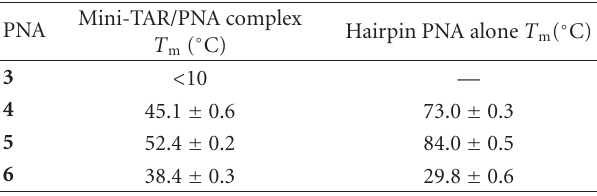
Table 1: Melting temperatures ( T m ◦ C) of Mini-TAR/PNA com- plexes and of hairpin PNAs